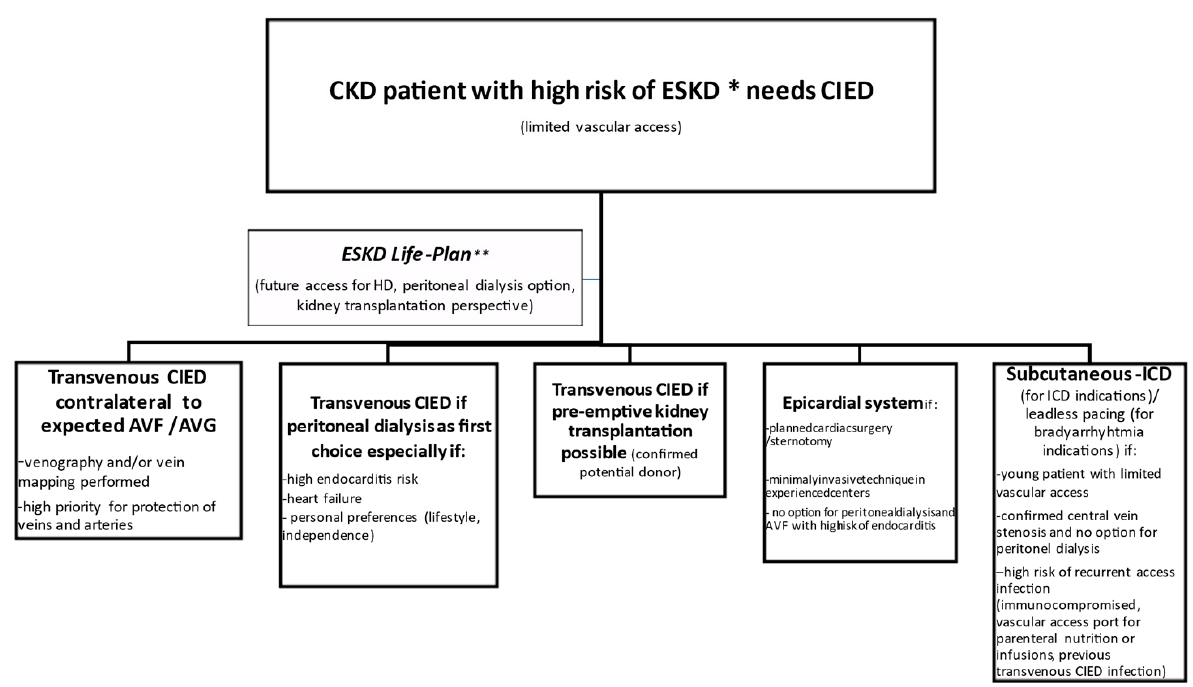
Figure 1. Decision-making on CIED in CKD patients with a high risk of ESKD or on dialysis. CKD—chronic kidney disease, ESKD—end-stage kidney disease, CIED—cardiovascular implantable electronic device, ICD—implantable cardioverter- defibrillator AVF—arteriovenous fistula, AVG—arteriovenous graft. * Estimated risk of progression to ESKD in CKD patients using (four or eight variables) KFRE is available at https://qxmd.com/calculate (accessed on 13 April 2021); ** ESKD Life-Plan approach in concordance with the KDOQI Clinical Practice Guideline for Vascular Access: 2019